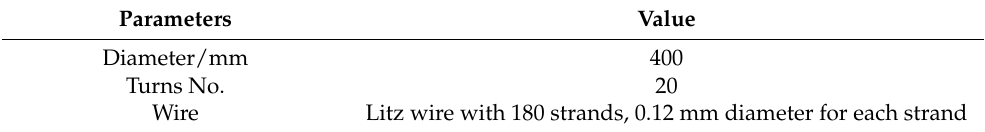
Figure 9. Wireless energy transmission test platform. Table 2. Parameters of transmitting coil.